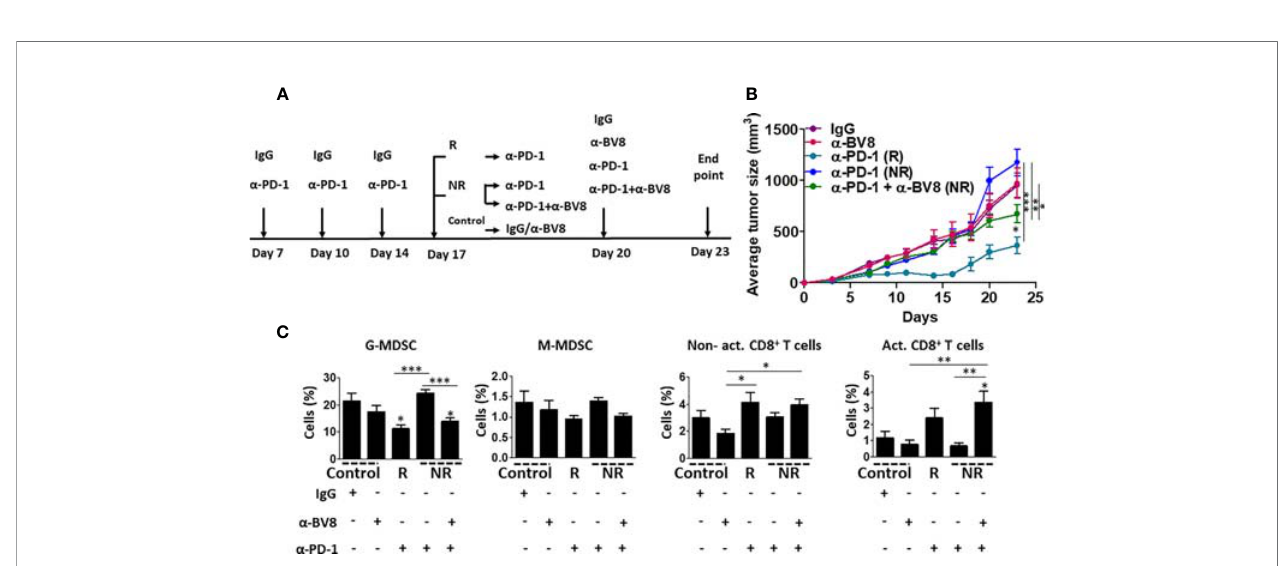
FIGURE 2 | Bv8 blockade sensitizes anti-PD1 resistant tumors. Eight-to-ten week old BALB/c mice (n=6-10 mice/group) were implanted with EMT6 cells (5x10 5 / mouse) in the mammary fat pad. When tumors reached 50 mm 3 , treatment with anti-PD1 or IgG control antibodies was initiated twice weekly and tumor growth was monitored. After three drug administrations, the mice were strati fi ed according to their response to treatment. Responder (R) mice continued anti-PD1 monotherapy. Non-responder (NR) mice were either treated with a combination of anti-PD1 and anti-Bv8 antibodies or continued anti-PD1 monotherapy. IgG-treated control mice were either switched to anti-Bv8 antibody monotherapy or continued receiving IgG control antibodies. (A) Treatment regimens for each group are shown. (B) Tumor growth per group is shown. (C) At the endpoint, tumors were removed and subsequently prepared as single-cell suspensions for the analysis of granulocytic and monocytic MDSCs (G-MDSC and M-MDSC, respectively) as well as non-activated and activated CD8+ T cells using fl ow cytometry. The results are presented as the percentage from CD45+ cells. The average percentage ± SD for each cell type, is shown in a bar graph. Statistical signi fi cance was assessed by one-way ANOVA followed by Tukey post-hoc test. Signi fi cant p values are shown as *p<0.05; **p<0.01; ***p<0.001 from control or otherwise indicated in the fi gure.